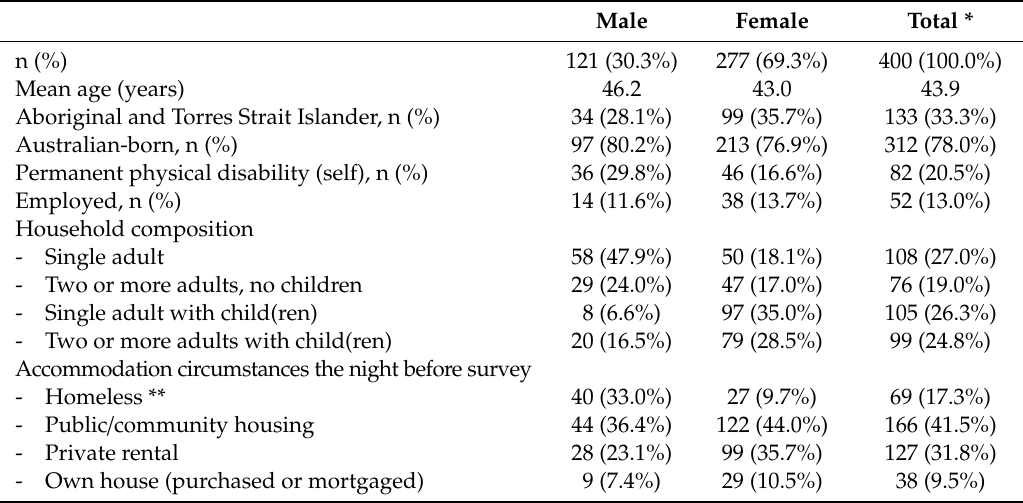
Table 1. Key sociodemographic characteristics of the sample.